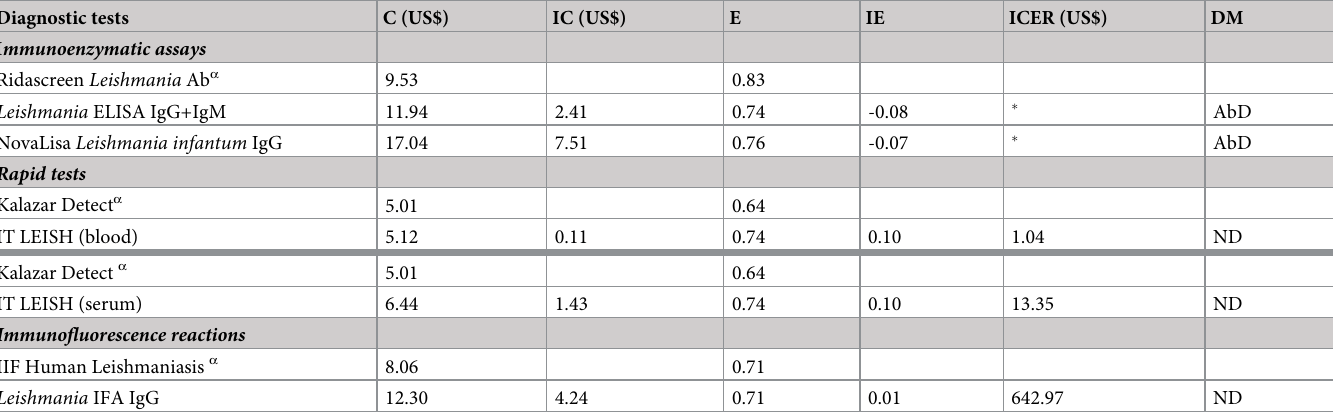
Table 6. Cost-effectiveness analysis for visceral leishmaniasis diagnostic tests in HIV-infected patients, stratified by test methodology. Diagnostic